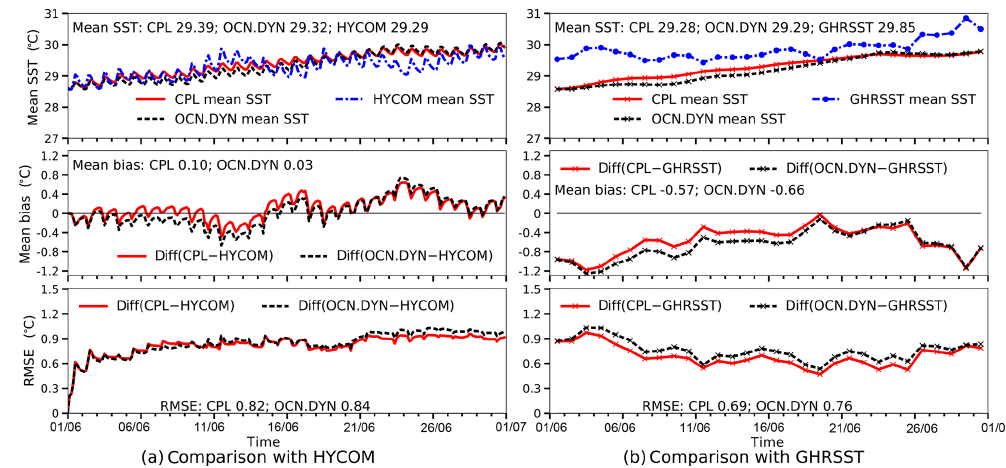
Figure 9. The bias and RMSE between the SST from the simulations (i.e., OCN.DYN and CPL) in comparison with the validation data. Panel (a) shows the 3-hourly SST obtained in the simulations compared with 3-hourly HYCOM/NCODA data. Panel (b) shows the daily SST at 00:00UTC (about 03:00 local time in the Red Sea region) obtained in the simulations compared with GHRSST. Both simulations are initialized at 00:00UTC 1 June